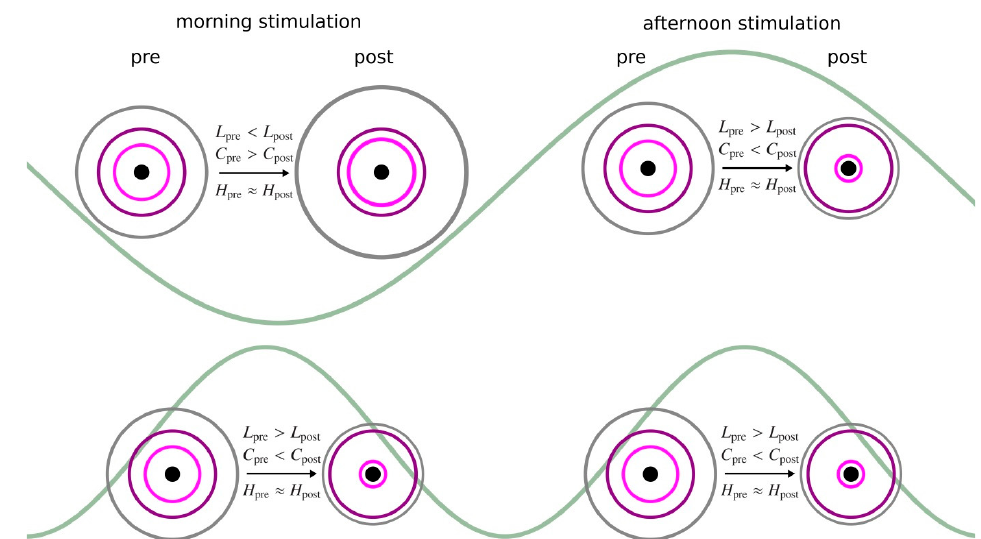
Figure 5. Schematic of spatial networks prior to and after taVNS stimulation in the morning ( left ) and in the afternoon ( right ), with different rhythmic activities (longer period lengths: top, shorter period lengths: bottom; indicated by greenish waves in the background) that interfere with the stimulation-mediated network modification. The network is separated into different areas based on network properties: (average clustering coefficient C and average shortest path length L ): boundary (gray outermost ring), periphery (purple and pink rings in the middle), and core (black innermost ring/circle). The larger the radius of a ring, the higher the L and the smaller the C of vertices in this area. The closer two rings, the more clustered the vertices are in the two areas relative to each other. Local importance hierarchies H (assessed with different centrality concepts) of vertices and edges are not affected by the